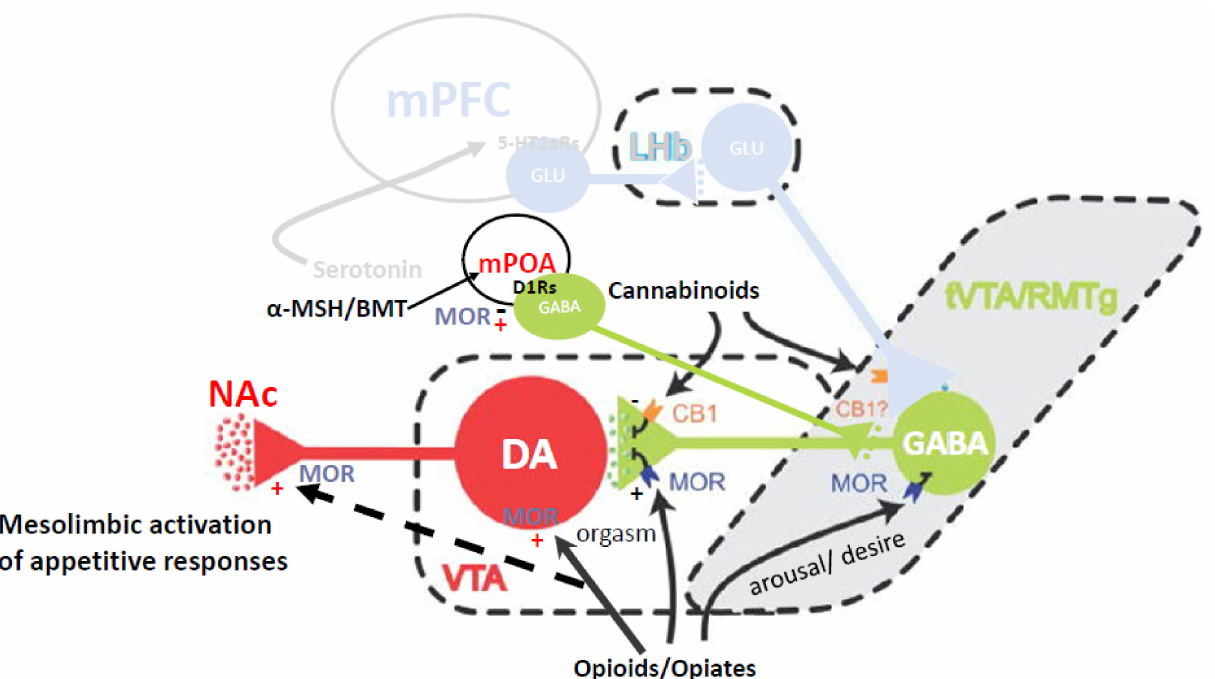
Figure 5. Neuroanatomical mechanisms of opioid inhibition and sensitization of mesolimbic and incerto-hypothalamic DA transmission. Opioids such as β -endorphin disinhibit dopamine